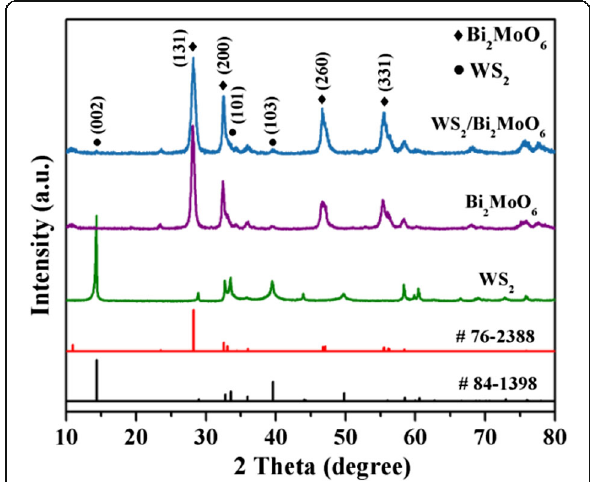
Fig. 1 X-ray diffraction patterns of Bi 2 MoO 6 , few-layer WS 2 , and WS 2 /Bi 2 MoO 6 (5 wt%)